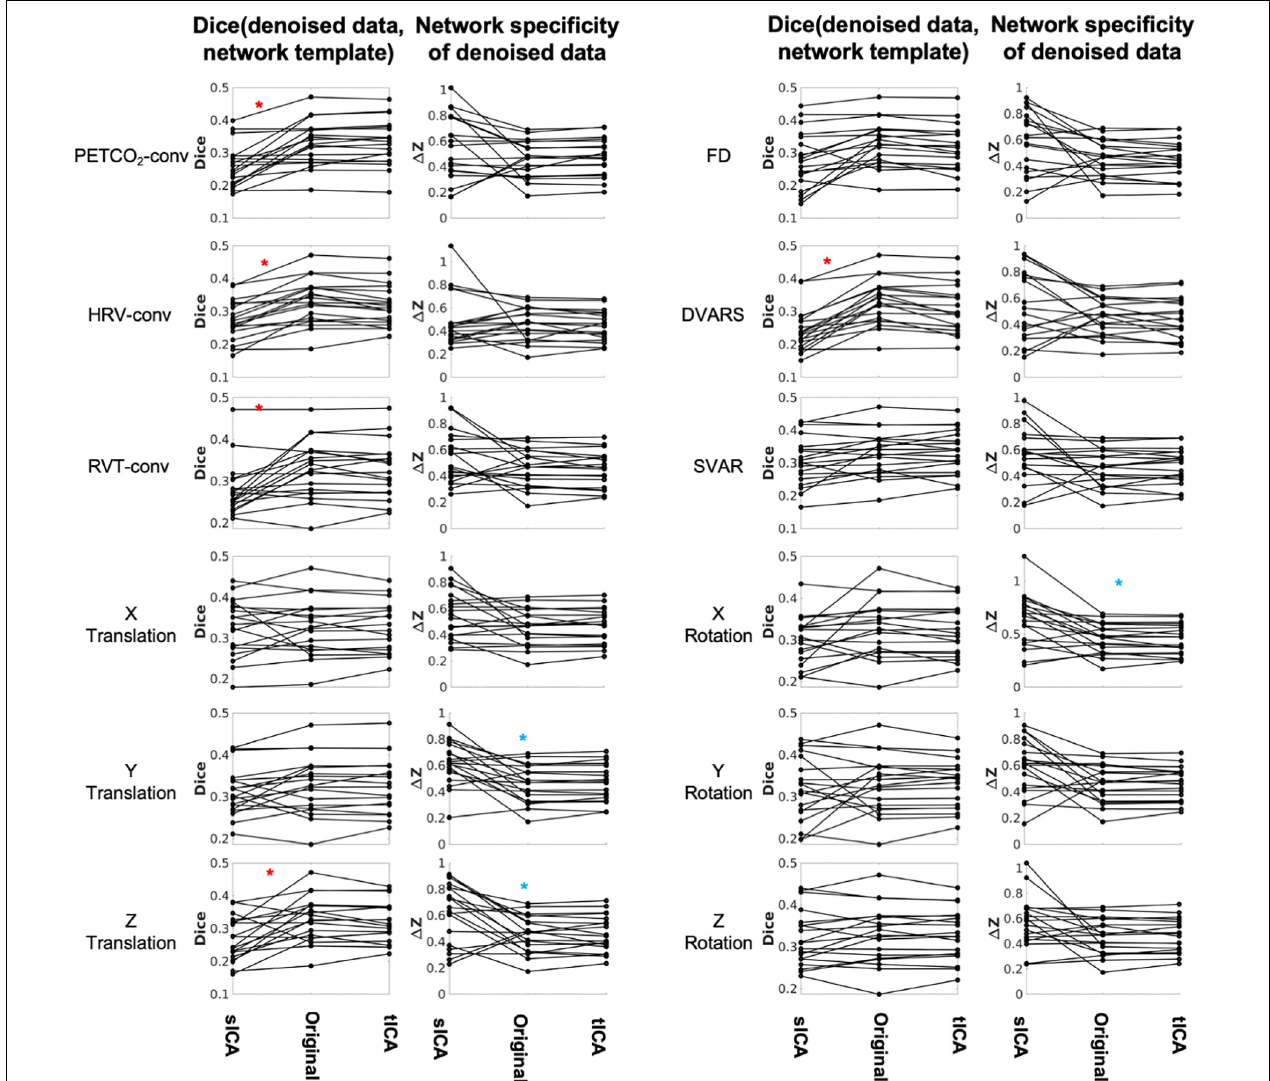
FIGURE 9 | Comparing sICA and tICA in removing the effect of physiological signals: Spatial overlap of connectivity pattern with known functional networks (Column 1) and intra-extra network difference (Column 2). Each line represents one subject. Column 1 represents the average Dice coefficient between the rs-networks template and the resting-state network maps generated from denoised fMRI data. Column 2 represent functional specificity of each connectivity map as measured by calculating the average (cid:49) Z between voxels within networks and those outside networks, and averaged over all networks. In each plot the ICA-denoising outcome is compared to the outcome from the original data (without ICA denoising). Significantly higher values for sICA are indicated by the blue asterisk, whereas significantly higher values for tICA are indicated by the red asterisks. The significance of the changes is indicated in boldface in Supplementary Tables 3 , 4